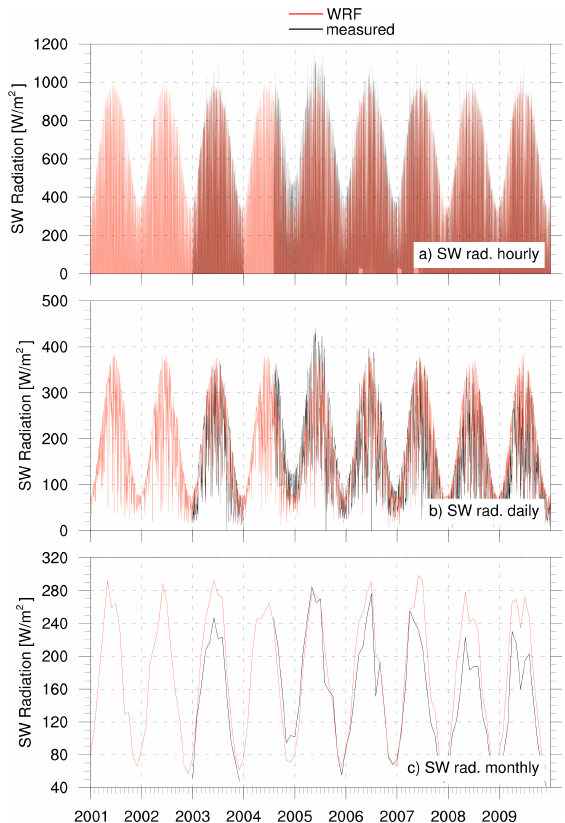
Figure 12. Incoming short-wave radiation modeled and measured at the station Loferer Alm (1623 m ASL) for the period 2001–2009. From top to bottom the panel shows hourly (top), daily (center), and monthly (bottom) aggregated